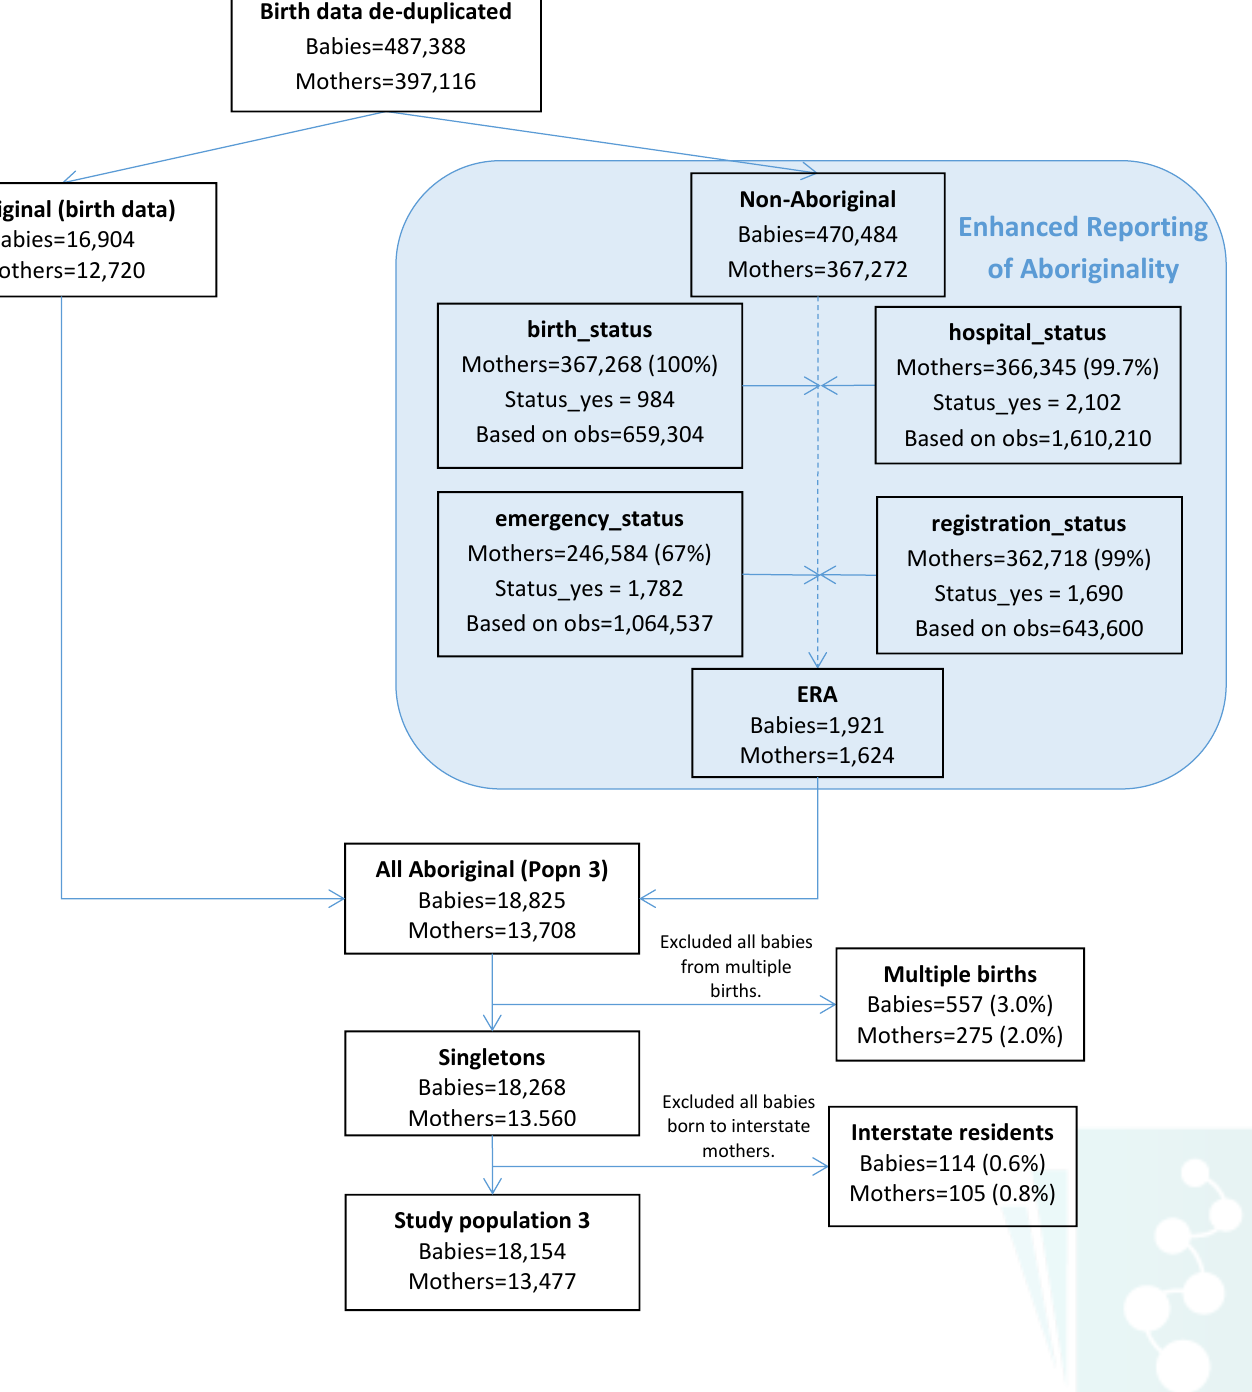
Figure 5: Flow diagram of mothers and babies eligible for inclusion in study population 3. Aboriginality of mothers in this study population was based on that recorded in the birth data and the enhanced reporting of Aboriginality using the multi-stage median algorithm and all available linked